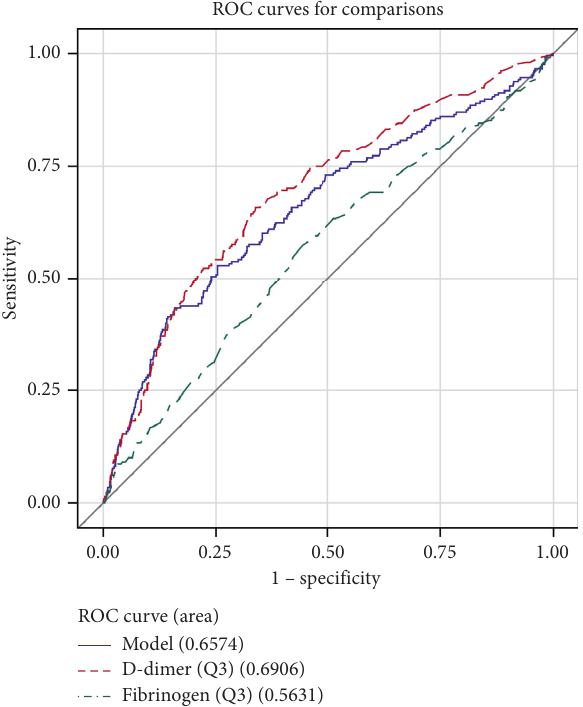
Figure 4: ROC curve for comparisons of D-dimer, fibrinogen, and combination of them in patients (60 < age ≤ 70).